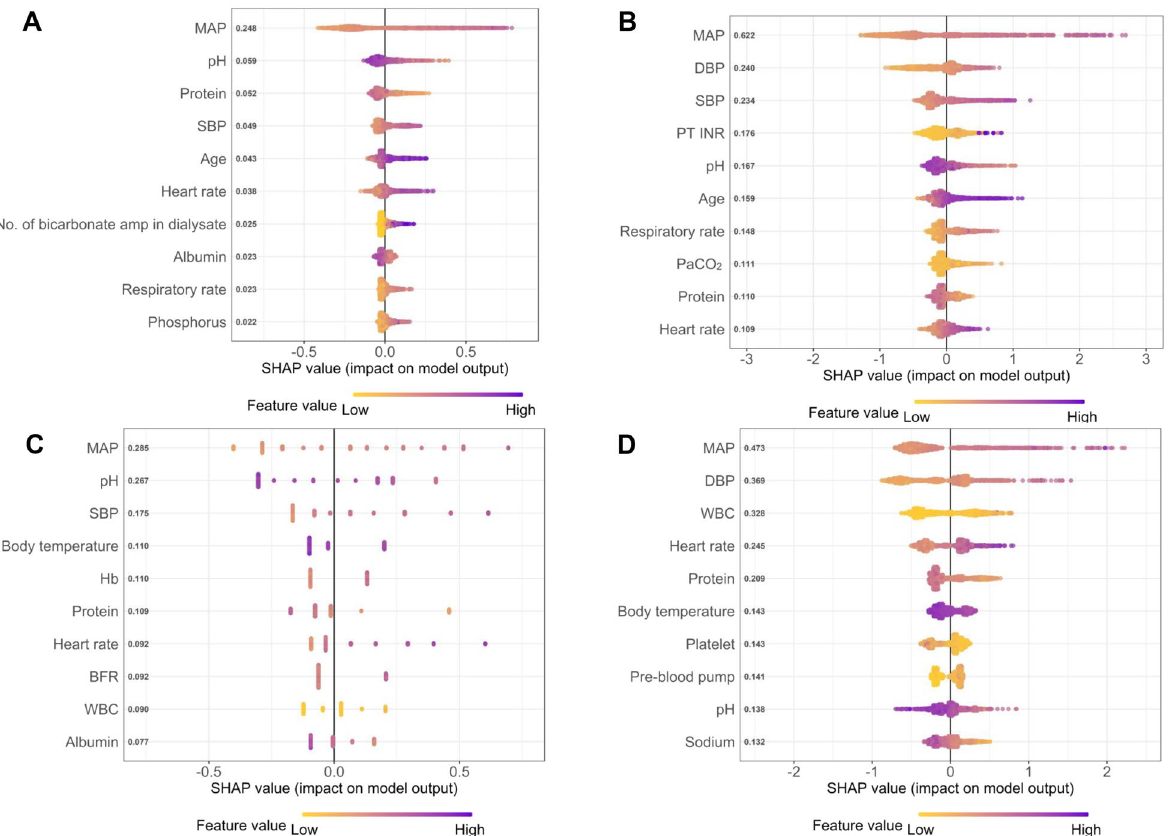
Figure 3. Feature ranking analysis of the extreme gradient boosting machine model in predicting a reduction in mean arterial pressure (MAP) ≥ 20 mmHg ( A , C ) and ≥ 30 mmHg ( B , D ) within 6 h ( A , B ) and 1 h ( C , D ). MAP mean arterial pressure, SBP systolic blood pressure, DBP diastolic blood pressure, PT-INR prothrombin time-international normalized ratio, PaCO